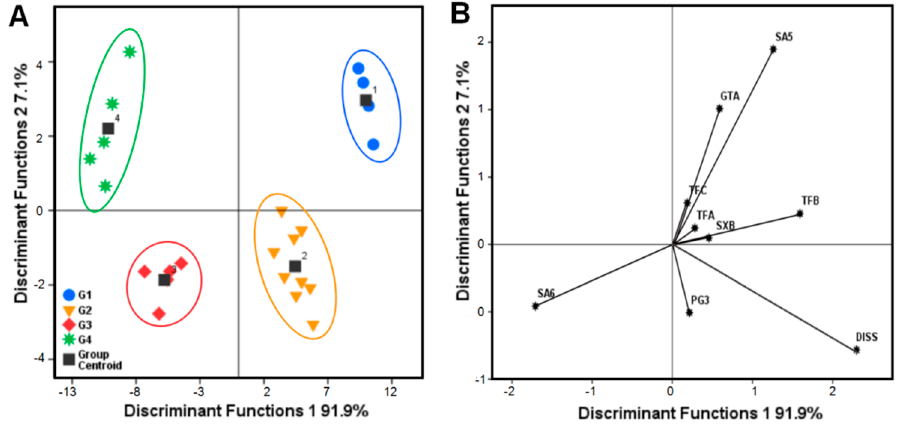
Figure 5. Quality discrimination analysis (DA) for P. tenuifolia samples from three different provinces. A : Scatter diagram of P. tenuifolia samples from four different groups (G1, G2, G3, and G4); B : Correlation chart between the variables and the discriminant functions for all of the P. tenuifolia samples. Note: DISS: 3,6 ′ -disinapoyl sucrose; SA5: sibiricose A5; SA6: sibiricose A6; SXB: sibiricaxanthone B; GTA: glomeratose A; PG3: polygalaxanthone III; TFB: tenuifoliside B; TFA: tenuifoliside A; TFC: tenuifoliside C.